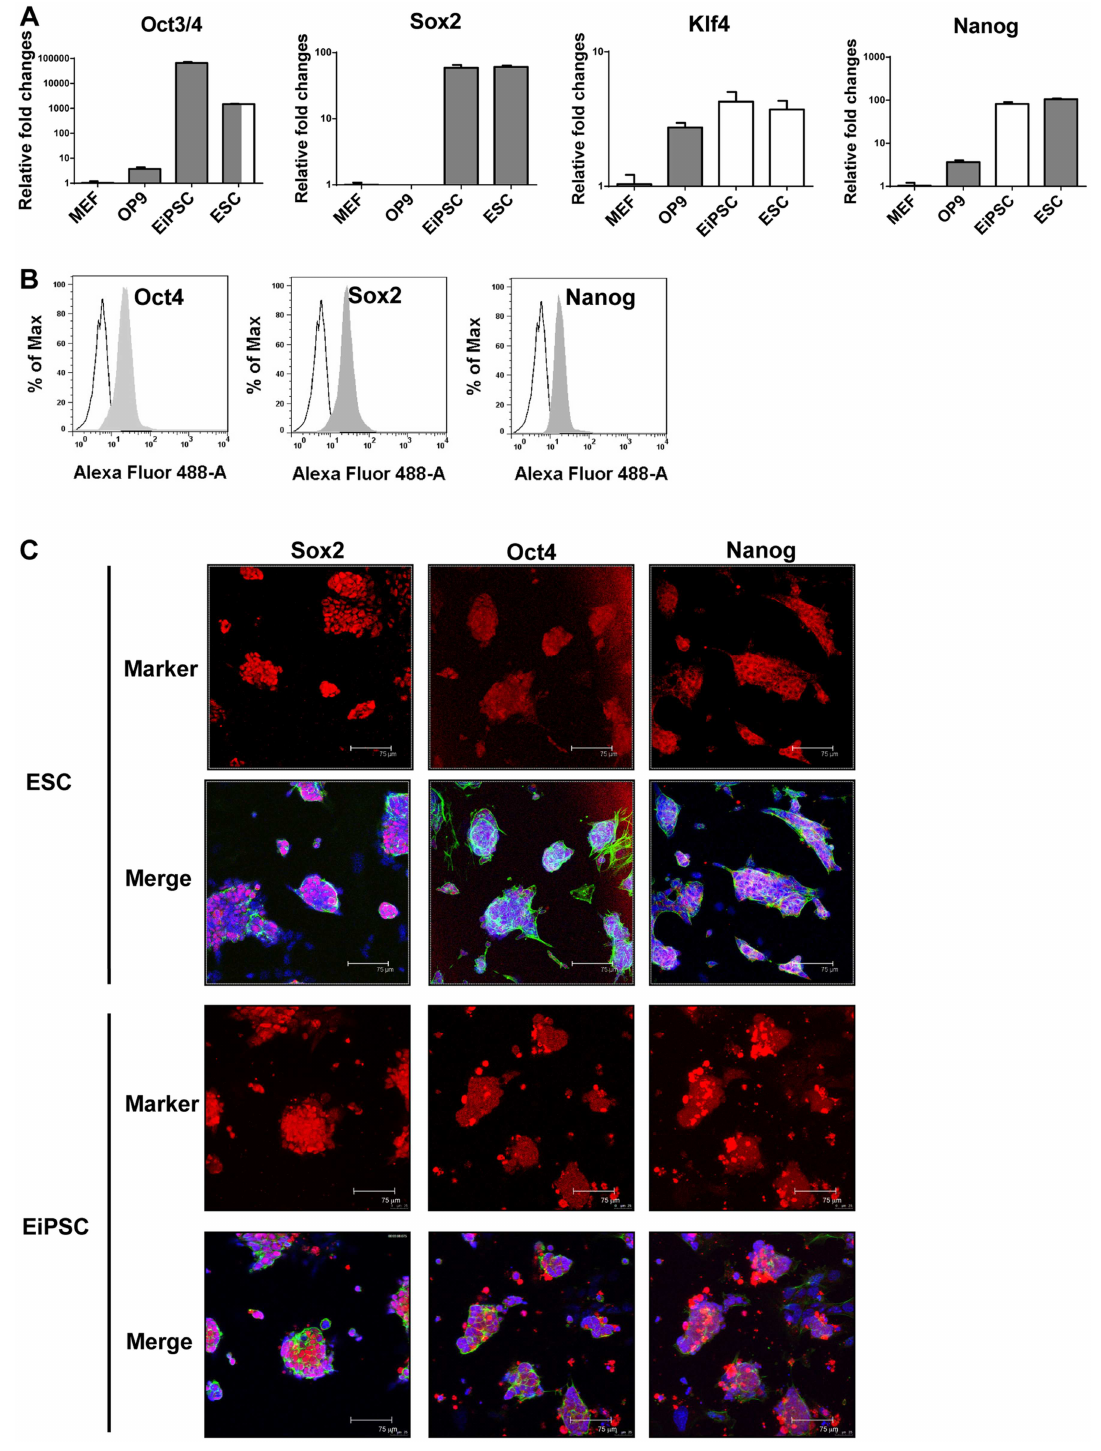
Fig 2. Characterization of EiSPCs. (A) The mRNA expression levels of pluripotent genes were quantifiedby real-time PCR in MEFs, OP9, EiPSCs and ESCs. (B) The pluripotentprotein levels within EiPSCs were quantifiedusing flow cytometry analysis. (C) Confocal microscopy images of immunocytochemistry staining for pluripotentprotein expressionin both EiPSCs and ESCs. Red fluorescence represents pluripotent protein expressionwhereas blue fluorescence represents DAPI staining for cell nuclei. Green fluorescence represents β -actin staining. Each scale bar represents 70 μ m.